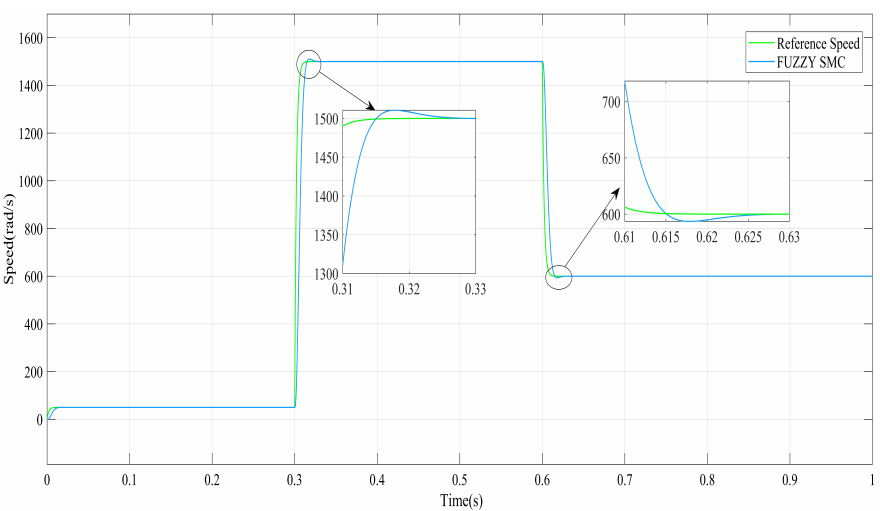
Figure 7. Fuzzy SMC speed